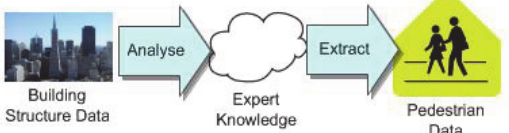
Figure 1. Concept model of pedestrian data extraction